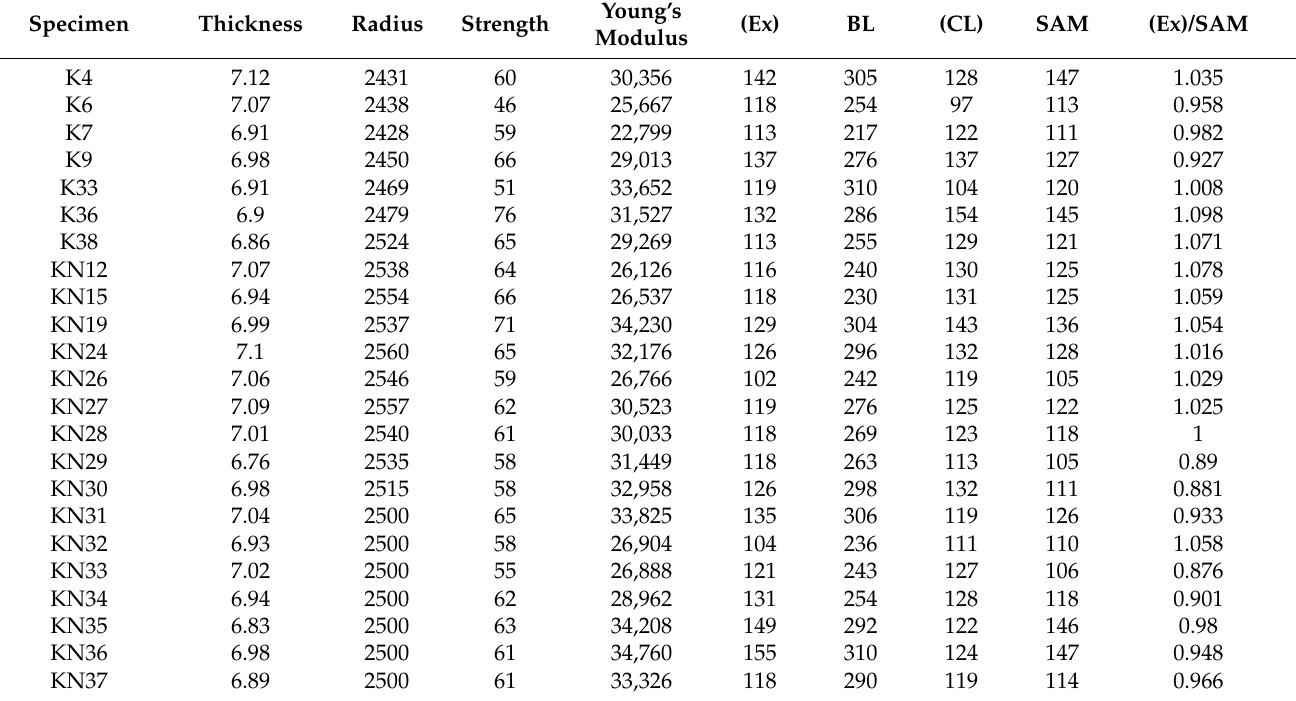
Table 1. Specimen data and result comparison.